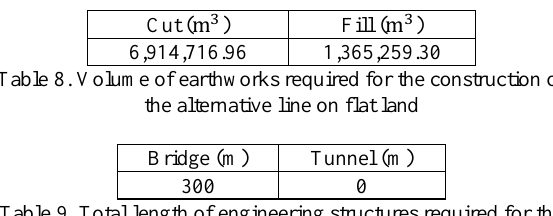
Table 9. Total length of engineering structures required for the construction of an alternative line on flat land